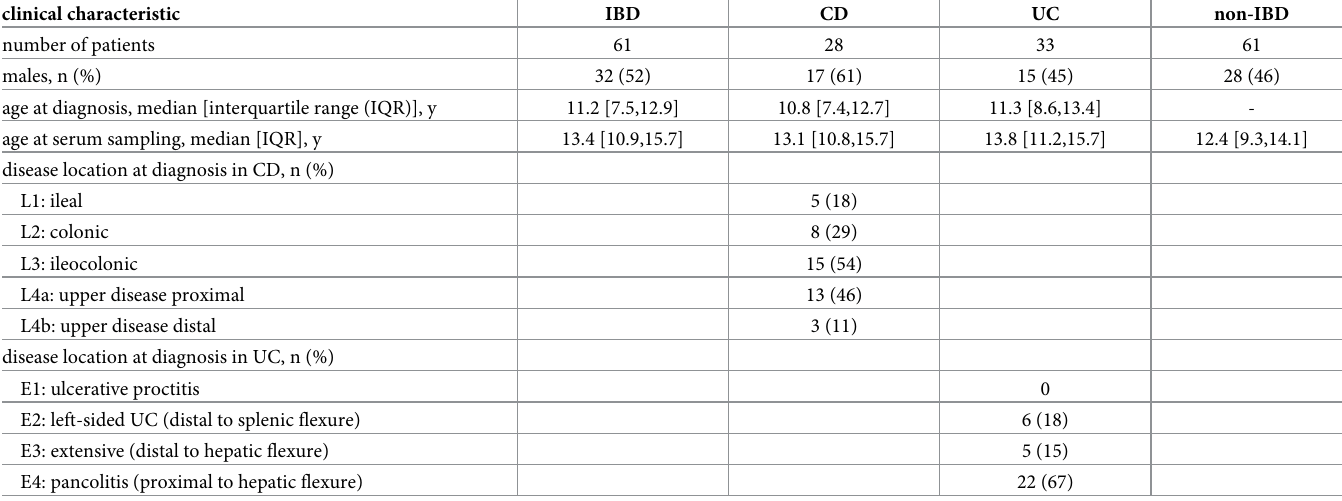
Table 1. Clinical characteristics of study population. clinical